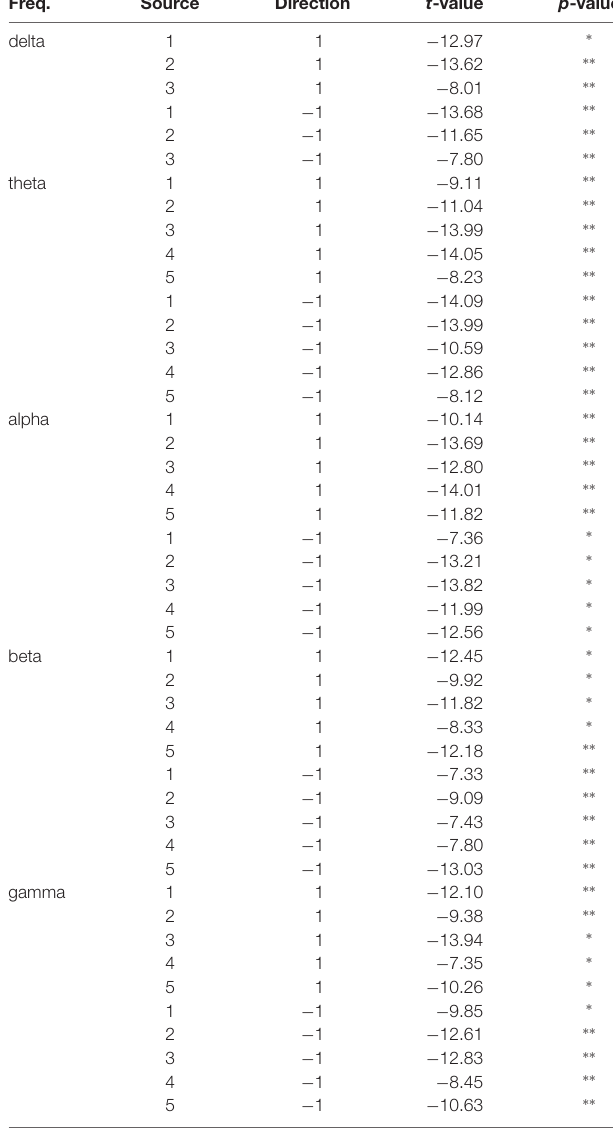
TABLE 3 | EEG differences related to renormalized partial directed coherence (RPDC) between healthy controls (HC) and MCI. Freq. Source Direction t -value p